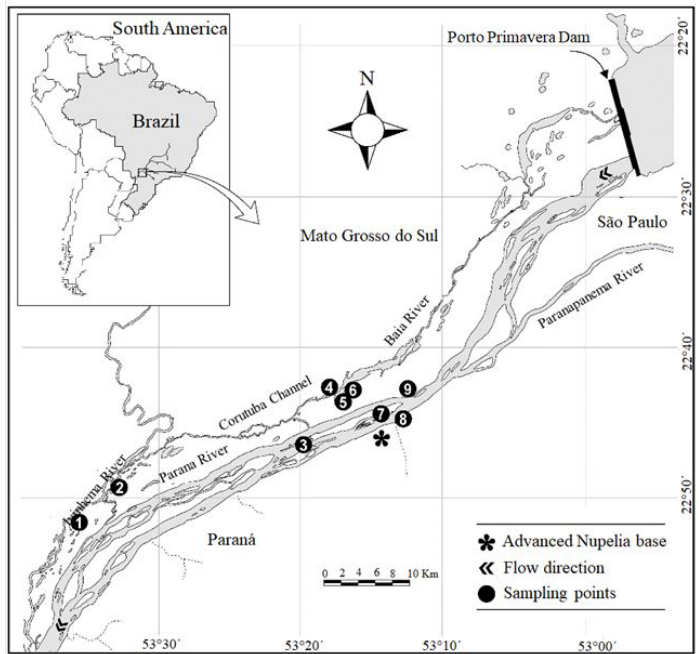
Figure 1. Sampling points of the high Paraná river floodplain in the Paraná sub-basin (PAR = Parana River, RES = Pau Véio Ressaco, GAR = Garças lake, OSM = Osmar lake, BAI= Baia river, GUA = Guarana lake and FEC = Fechada lake) and Ivinhema (IVI = Ivinhema River; PAT = Patos lake;